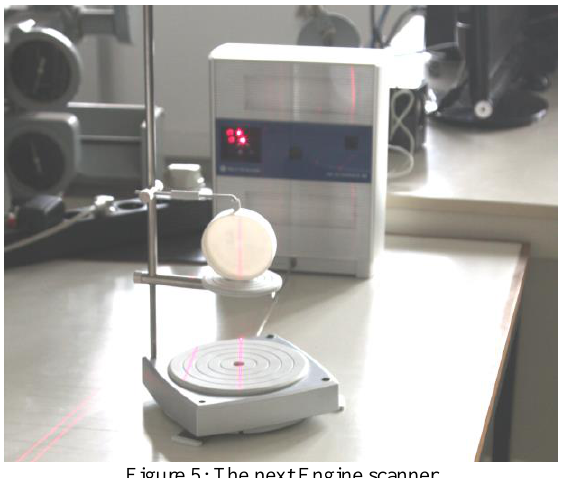
Figure 5: The next Engine scanner